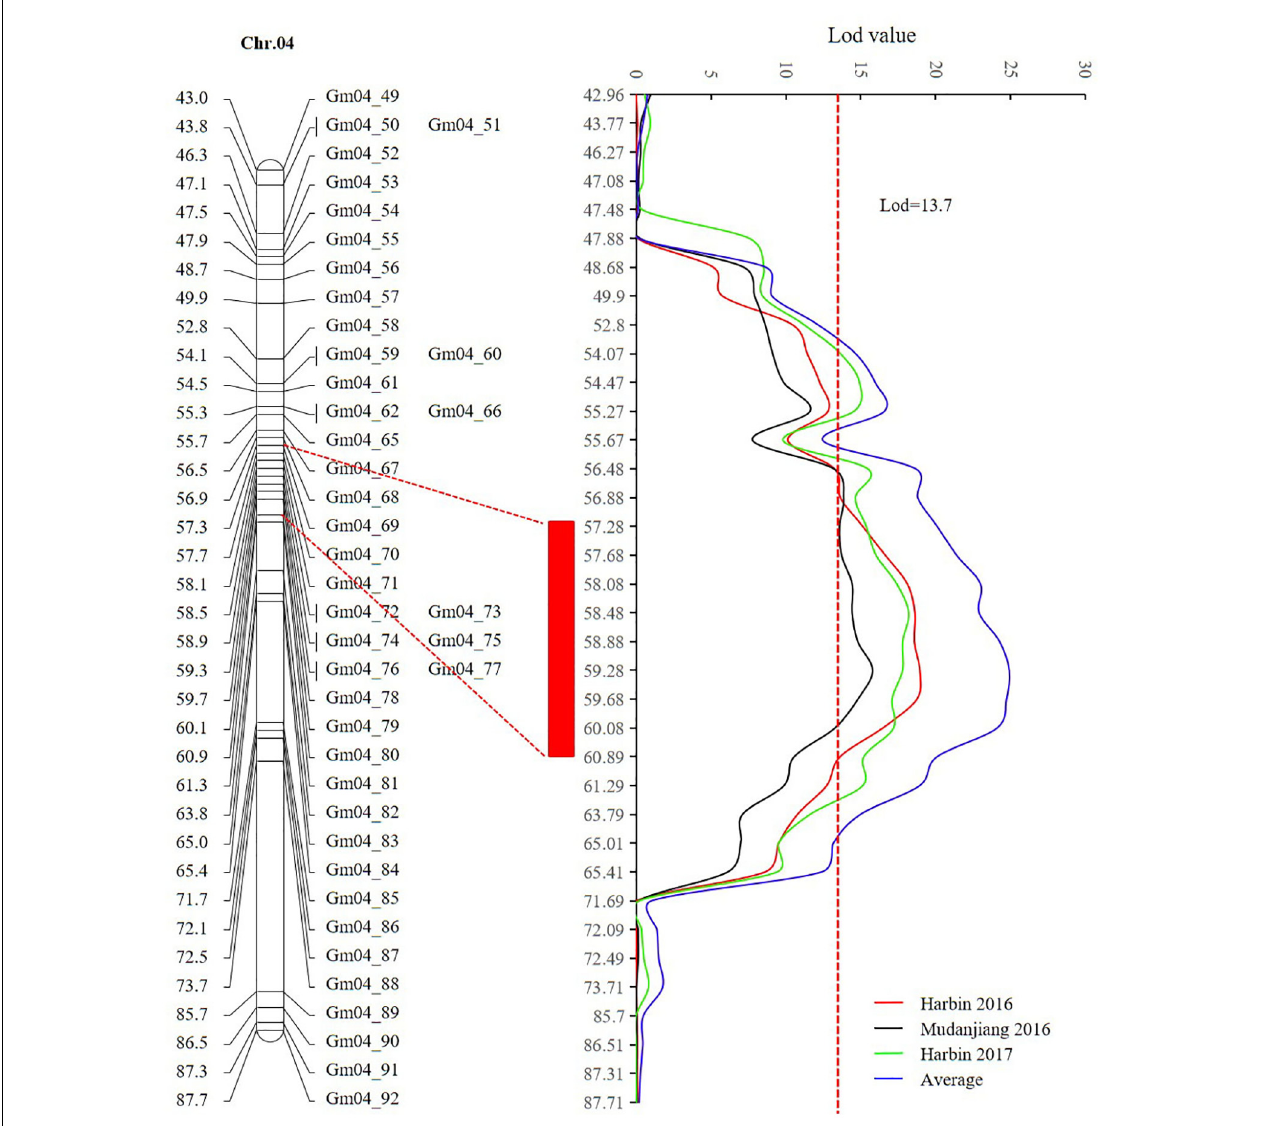
FIGURE 6 | The high confidence interval of QTL detected on chromosome 4 (CIM method). The red rectangle represents the high confidence interval between markers Gm_69 and Gm_80 with physical positions from 13,212,370 to